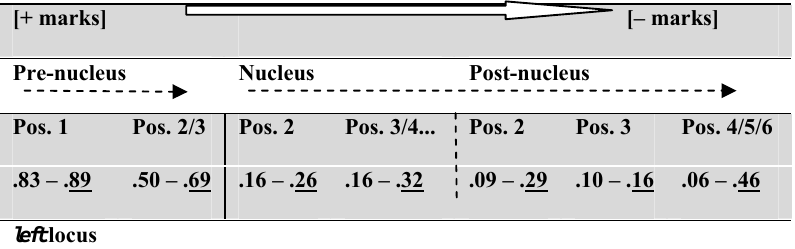
Figure 2. Continuum of plurality marking on prototypical NPs in BP and STP, based on WRs obtained within the different analyses carried out [+ marks] [–